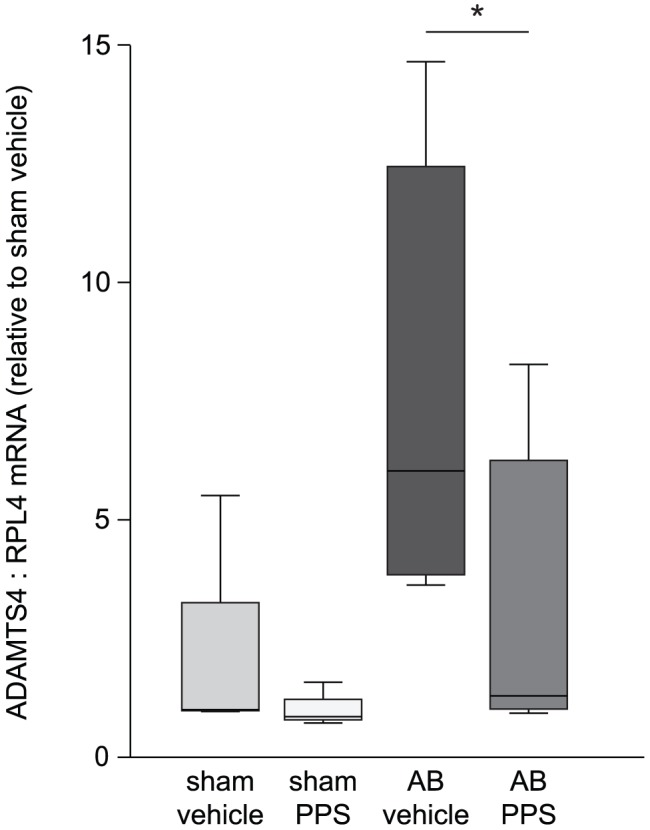
Decreased myocardial ADAMTS4 mRNA level after PPS-treatment.Myocardial mRNA expression of ADAMTS4 in rats treated with PPS (n = 10) or vehicle (n = 7) six weeks after AB, and in sham-operated rats treated with PPS (n = 3) normalized to the reference gene RPL4 and relative to vehicle-treated sham (n = 3). Box-plots show median (horizontal line), interquartile range (box), 1.5xinterquartile range or maximum/minimum range (whiskers) and outliers (>1.5xinterquartile range). *p<0.05. AB, aortic banding; PPS, pentosan polysulfate; HF, heart failure; RPL4, ribosomal protein L4.